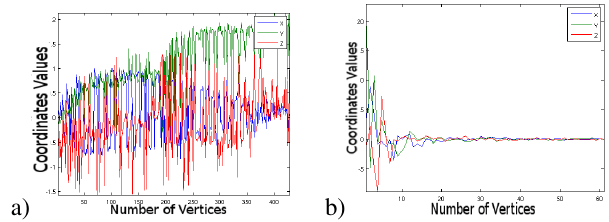
Figure 2: Plot of the spectral x Cartesian coordinates of a single mesh. a) Cartesian coordinates. b) spectral coordinates.